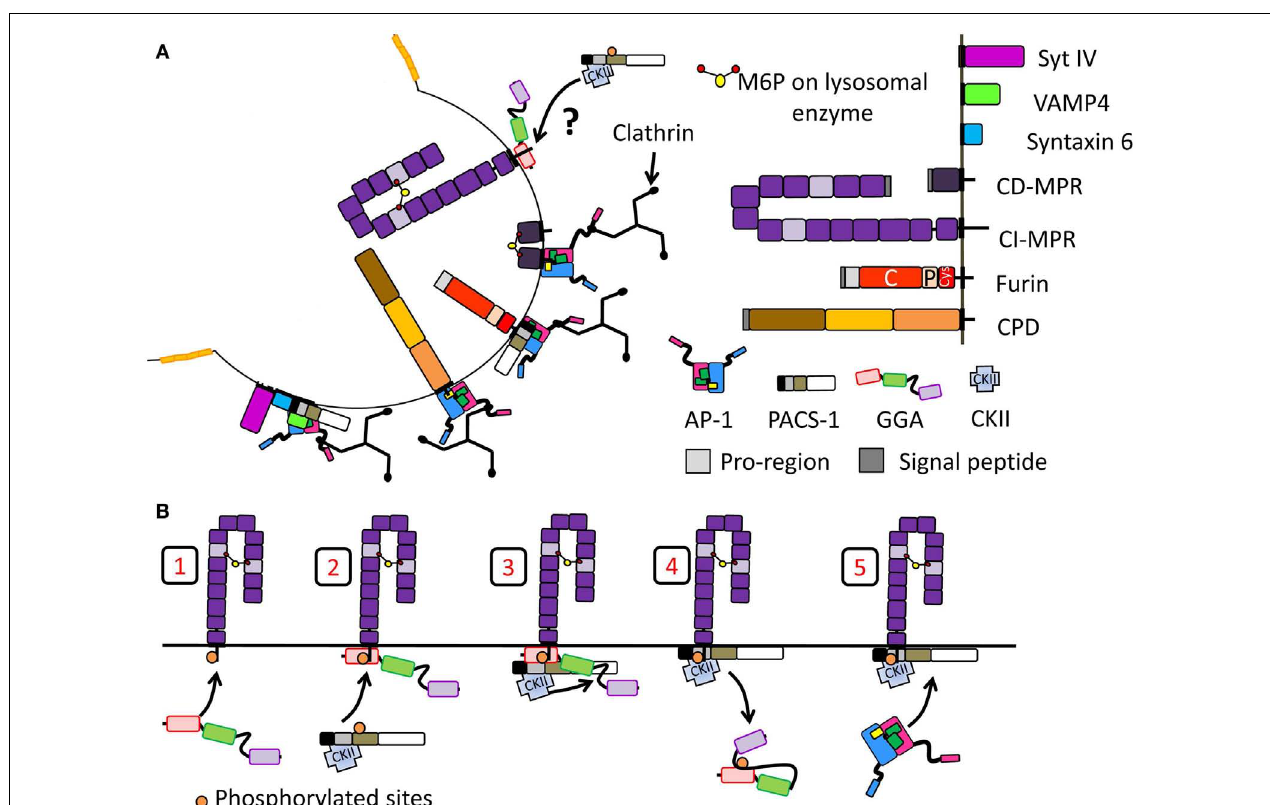
retrieval. (B) Model of adaptor protein recruitment for CI-MPR transport: GGA3 binds CI-MPR cytosolic tail (step 1).Then, PACS-1, presumably already interacting with CKII, is recruited to the GGA3/cargo complex (step 2). CKII phosphorylates the GGA3 hinge autoinhibitory region (step 3) resulting in GGA3 dissociation from membranes (step 4). PACS-1 then recruits AP-1 for the CI-MPR transport (step 5). Model adapted from